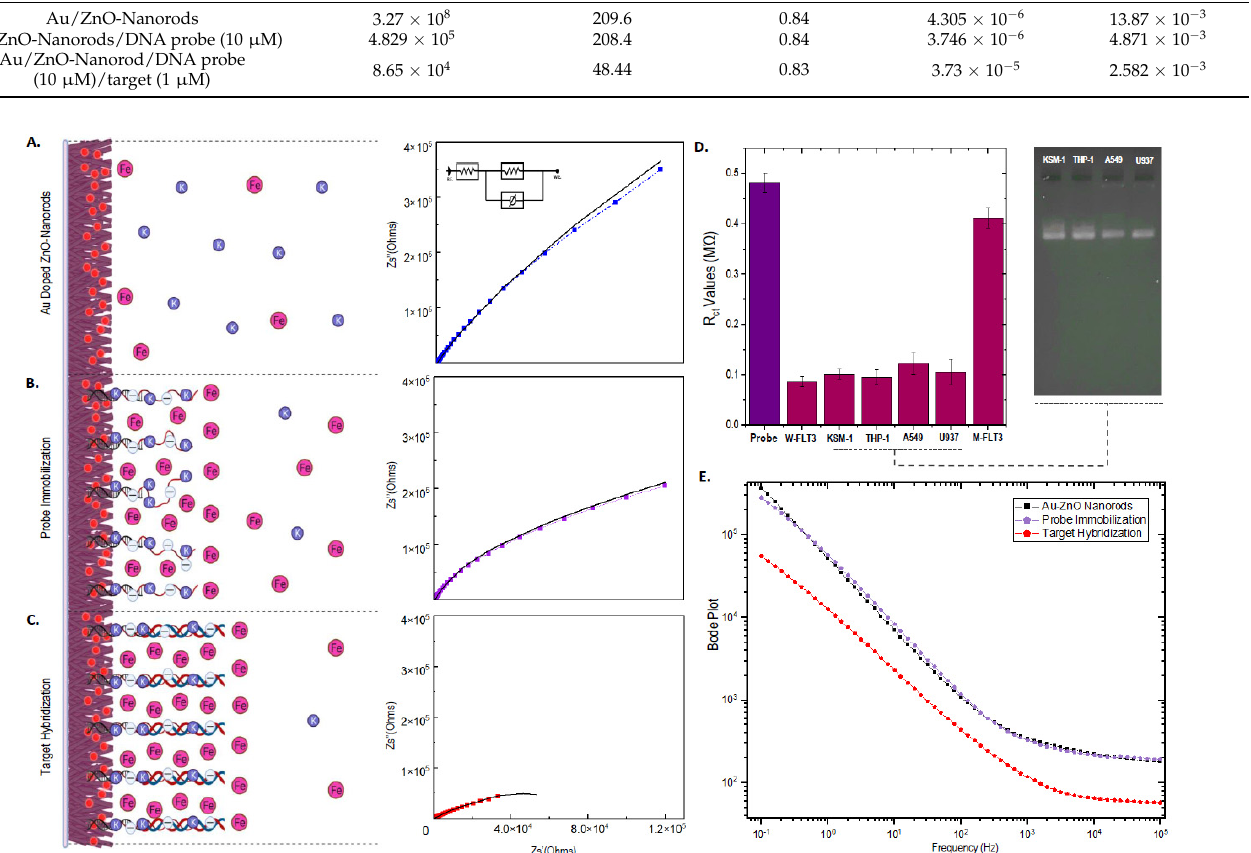
Figure 6. Schematic illustrations showing electrochemical behaviour on top the sensor surface and the surrounding electrolyte solutions with corresponding EIS spectrums obtained during measurement of ( A ) Au-sputtered ZnO-nanorods, ( B ) probe immobilization, and ( C ) target hybridization. ( D ) Bar chart of R ct values measured for FLT3 target sequence obtained from different cell lines and with mutated FLT3 gene sequence, included with gel image of normal FLT3 from AML and non-AML cell lines. ( E ) Bode magnitude plot for the different stages of chip fabrication and target hybridization.